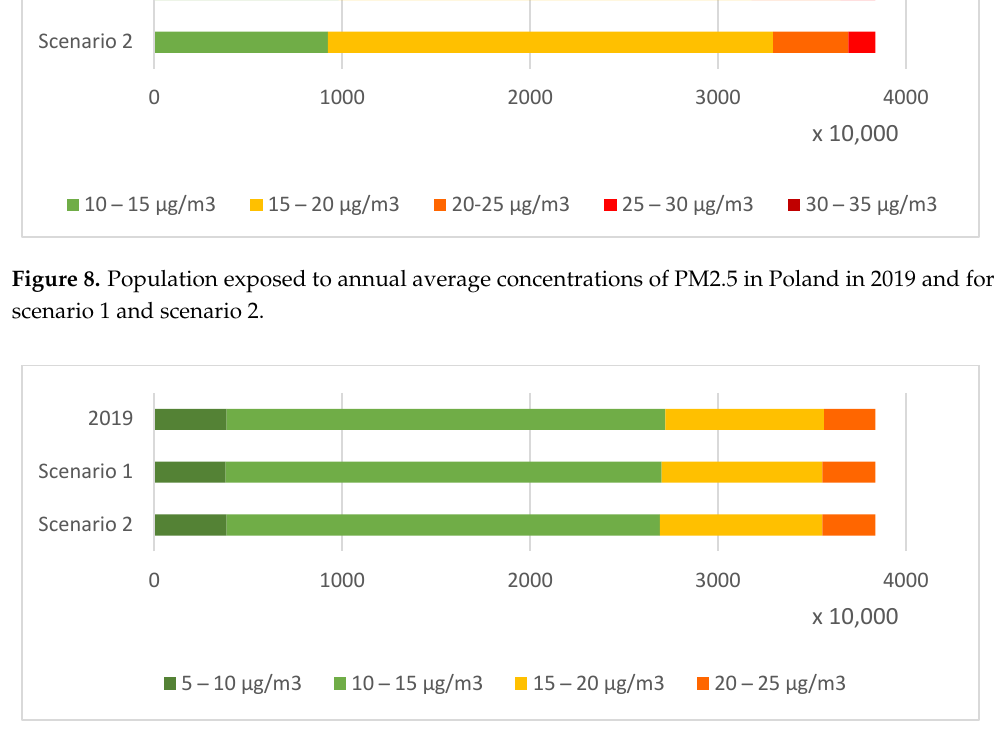
Figure 9. Population exposed to annual average concentrations of NO 2 in Poland in 2019 and for scenario 1 and scenario 2.